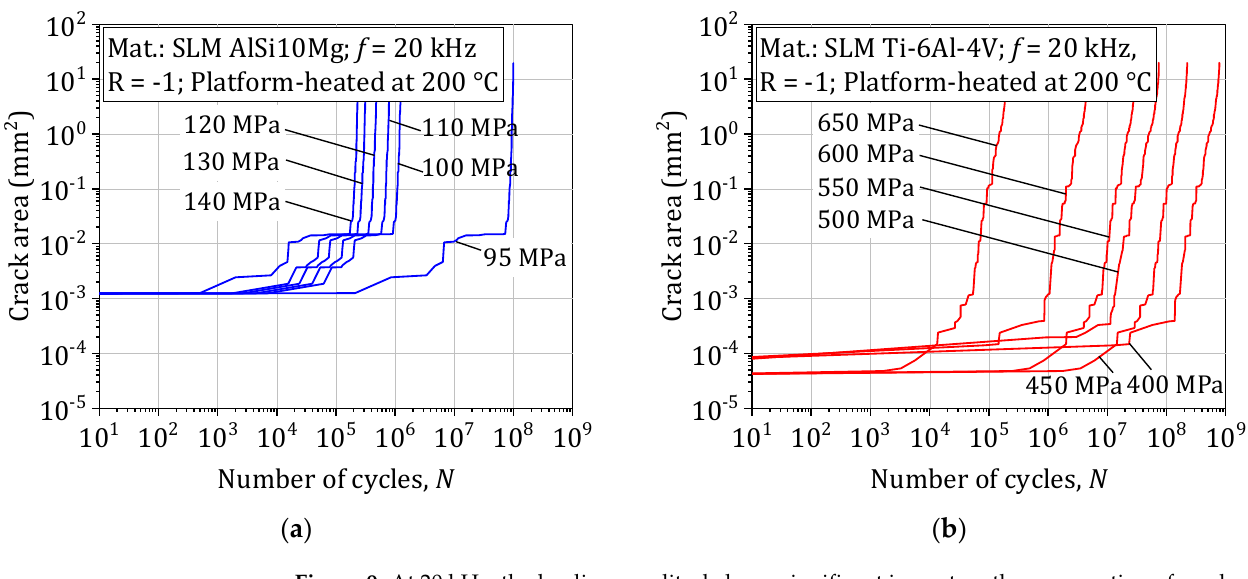
Figure 9. At 20 kHz, the loading amplitude has a significant impact on the propagation of cracks: ( a ) AlSi10Mg and ( b ) Ti-6Al-4V are available. Table 3. Comparison between experimental and numerical fatigue